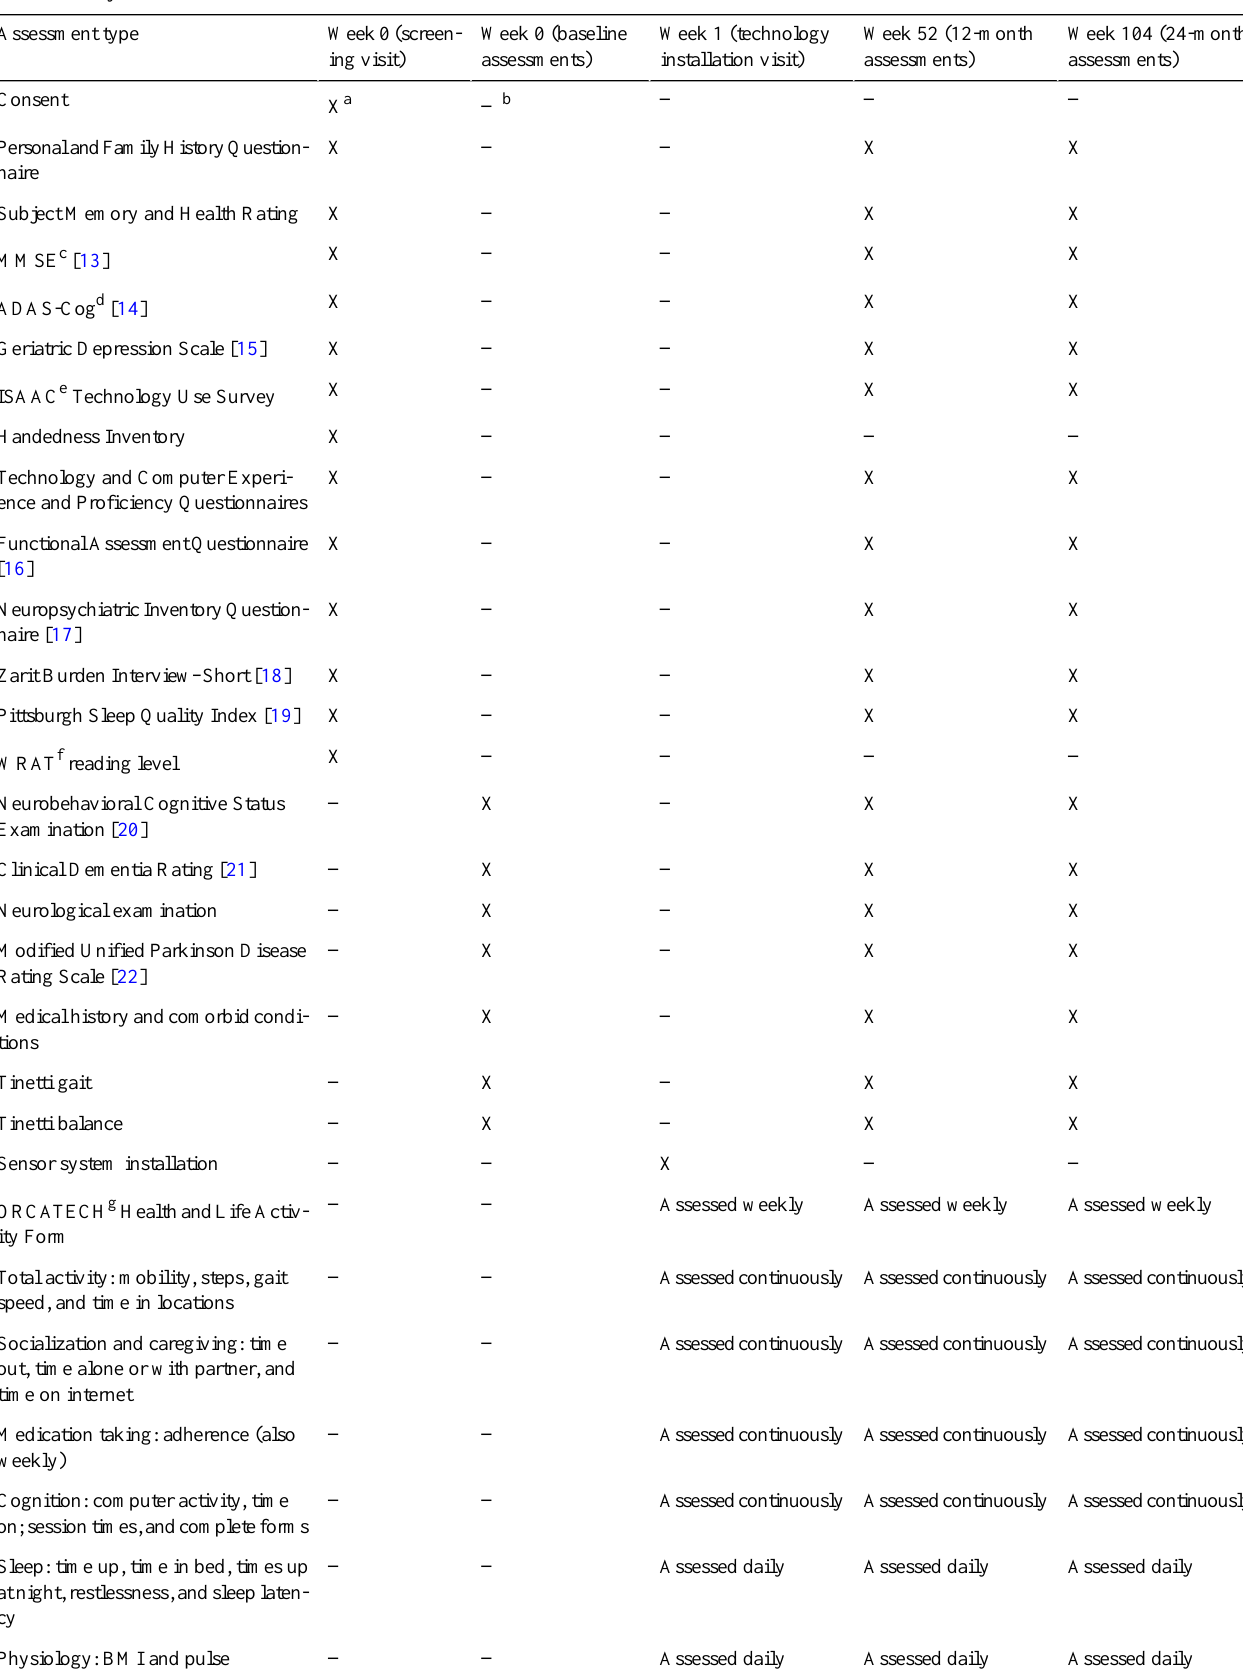
Table 1. Study schedule of